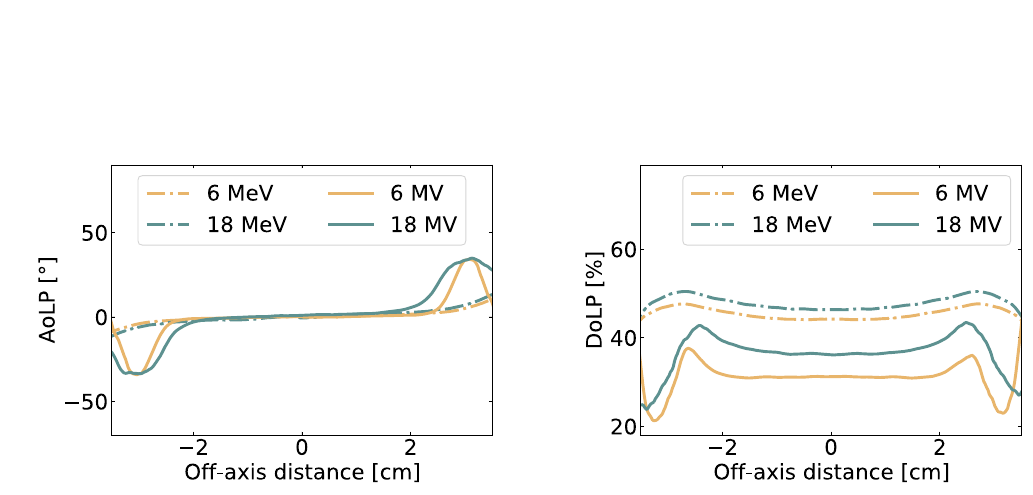
Table 1. Comparison of the mean degree of linear polarization (DoLP) of scintillation and Cherenkov emission. DoLP = I pol / I tot × 100 .